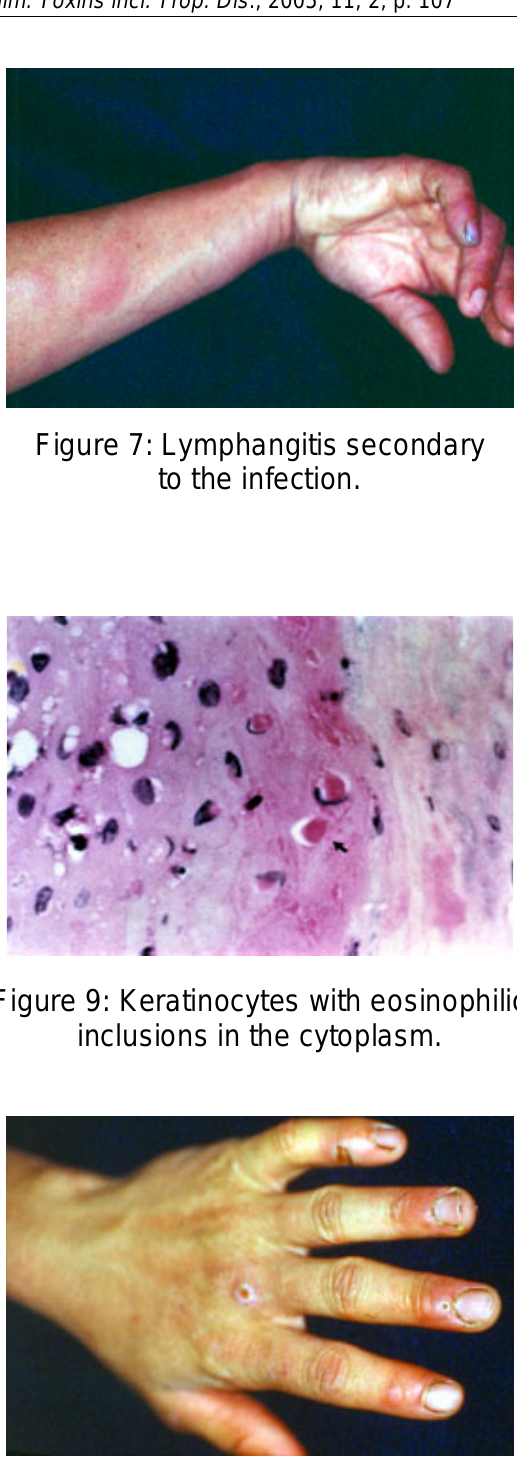
Figure 11: Umbilicated lesion and presence of inflammation in the ungual folds.